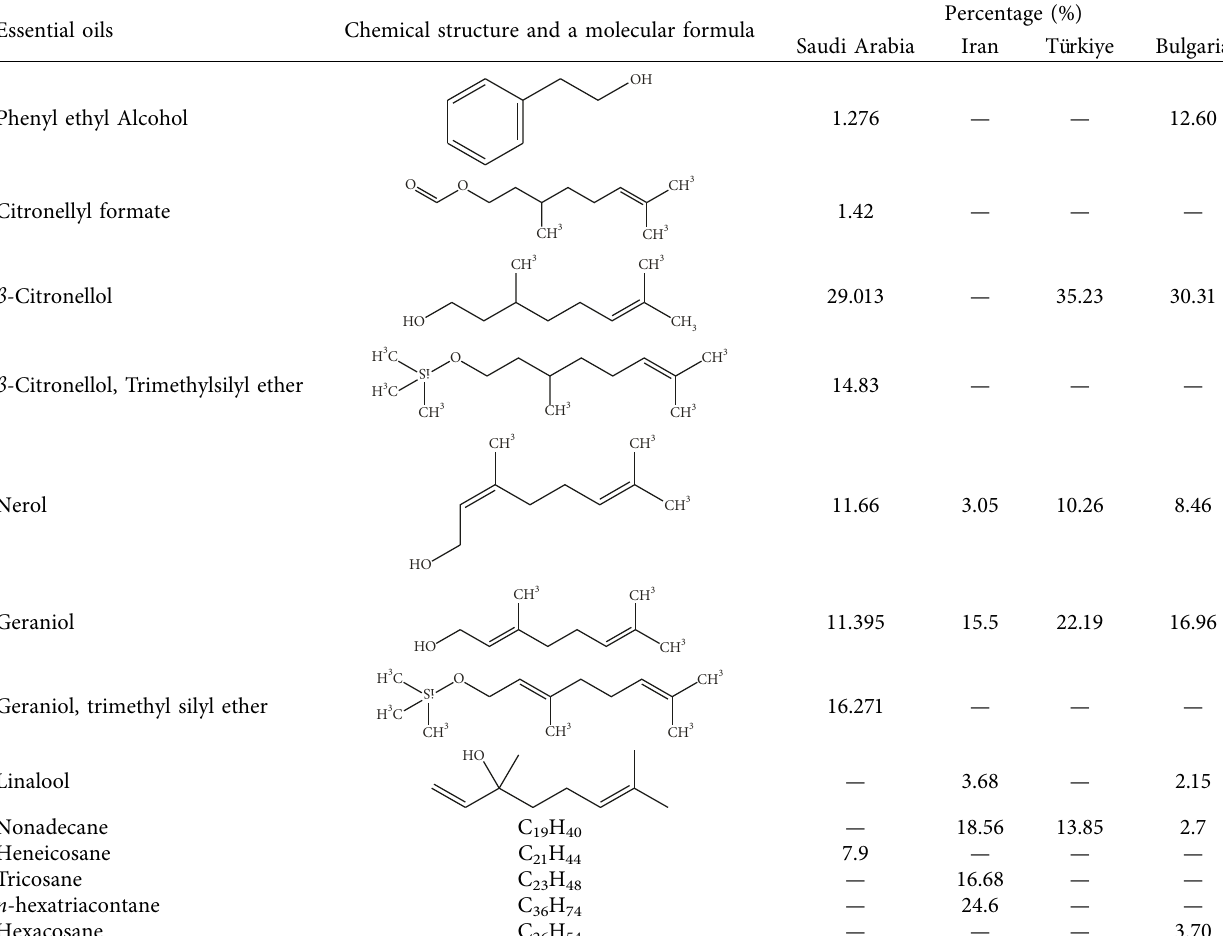
Table 1: Comparison data of quantity of R. damascena essential oils in different countries. Essential oils Chemical structure and a molecular